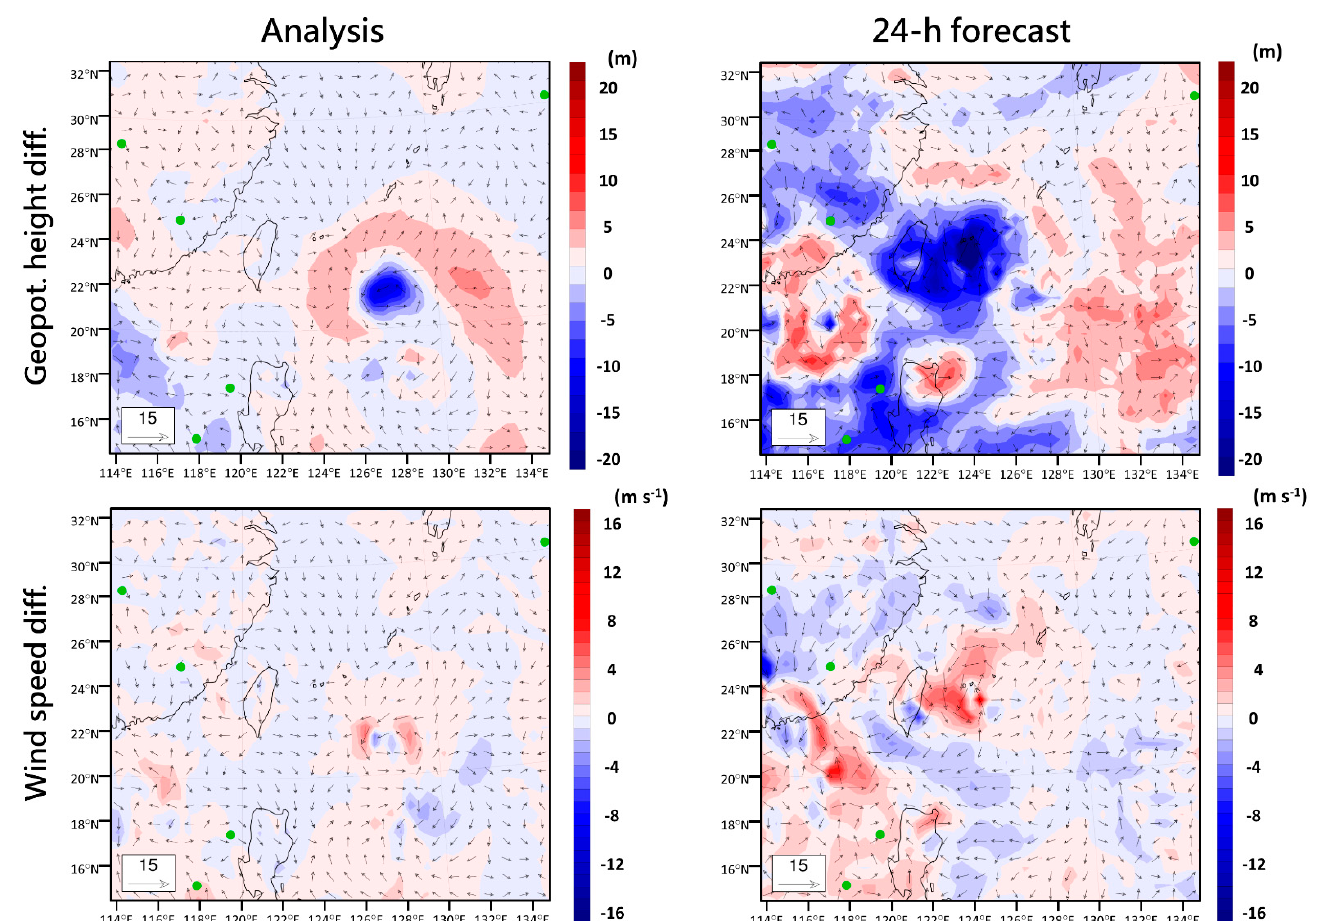
Figure 15. The 850-hPa ( a ) geopotential height difference and ( b ) wind speed difference of WRF Member 2 minus WRF Member 1 at 24 h for the forecast sample initialized at 12:00 UTC 1 August 2020. The arrows indicate the wind difference. The green dots denote the COSMIC-2/FORMOSAT-7 RO observations assimilated by WRF Member 2. The dark blue shad- ing indicates terrain.